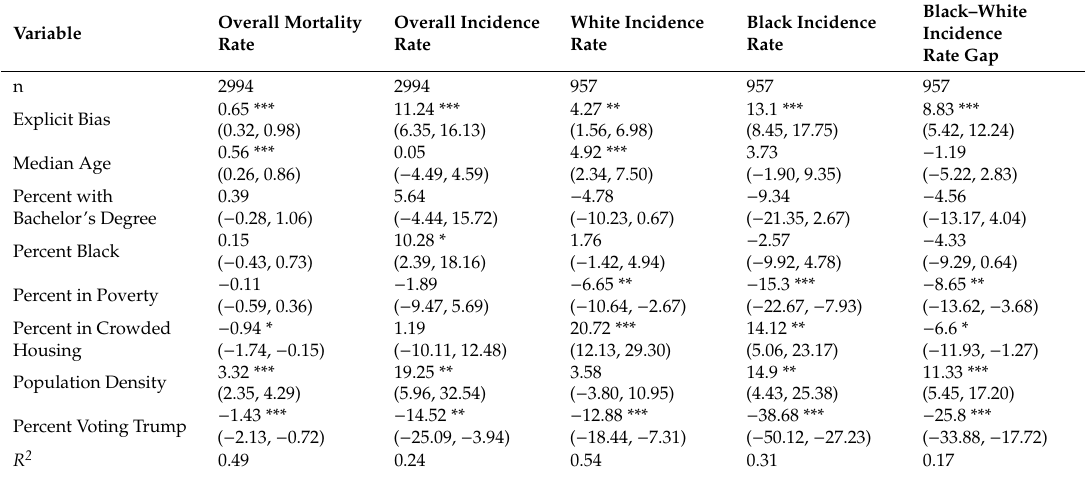
Table A5. Predicted shift in COVID-19 rates associated with a one standard deviation increase in explicit bias (adjusted for other predictors), per 10,000 individuals in the